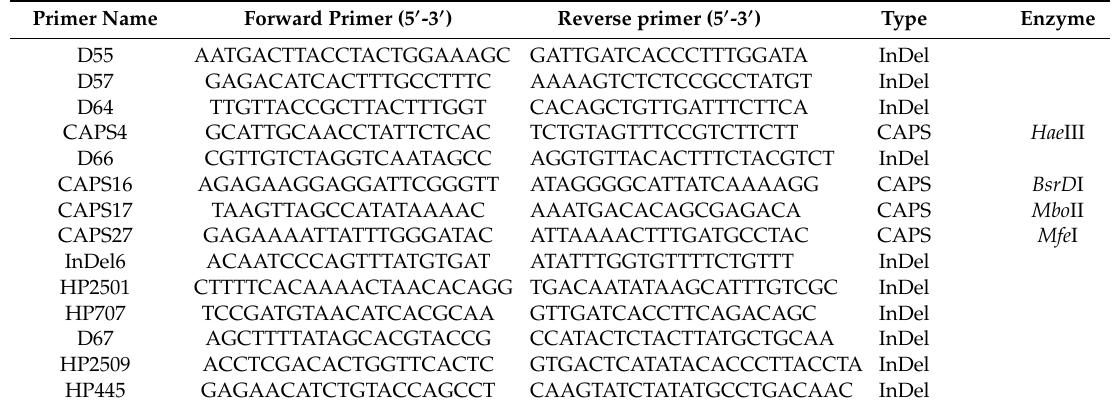
Table 4. Markers used for mapping of EI